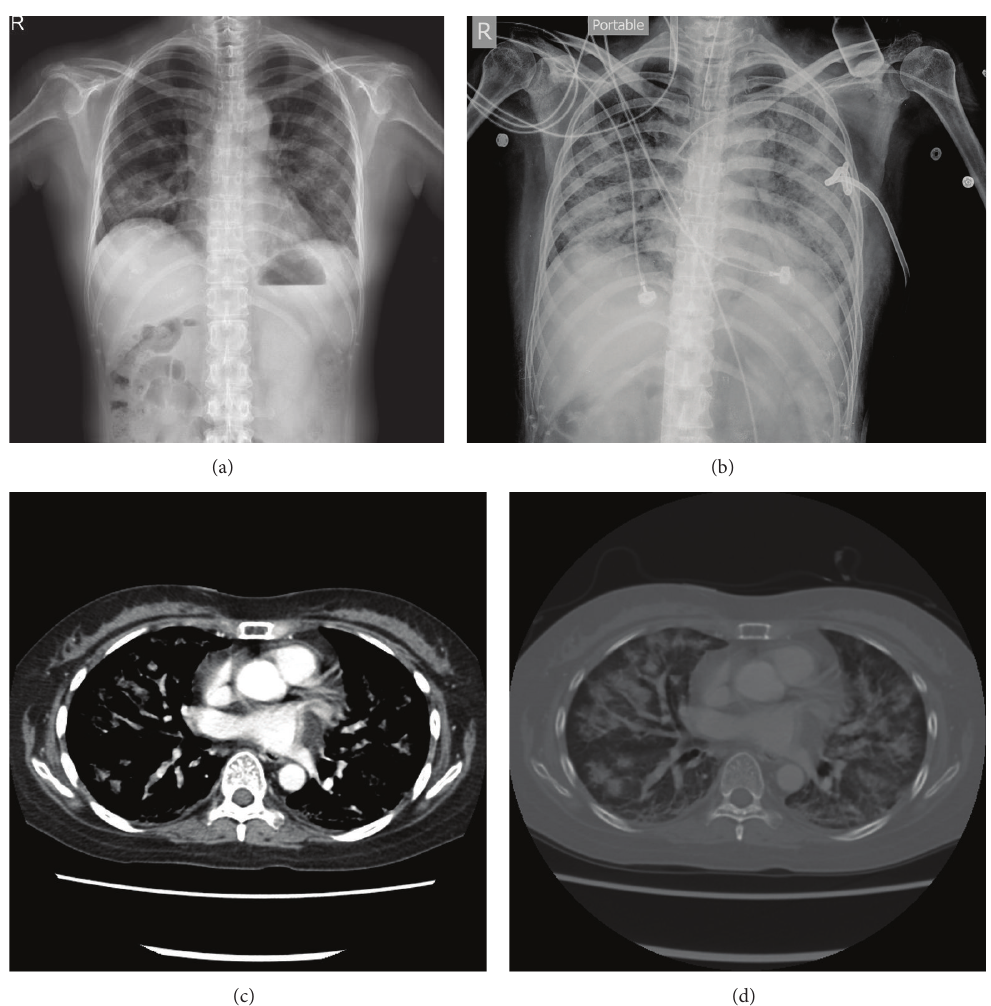
Figure 1: (a) Admission anteroposterior chest radiography shows multilobar solitary nodules and consolidation. (b) Anteroposterior chest